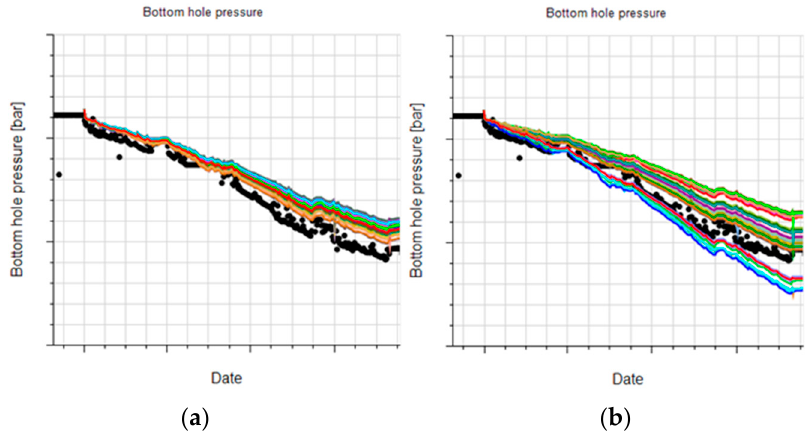
Figure 4. The coverage of observed data (black dots) by the initial ensembles. ( a ) Monte Carlo sampling; ( b ) proposed sampling procedure.